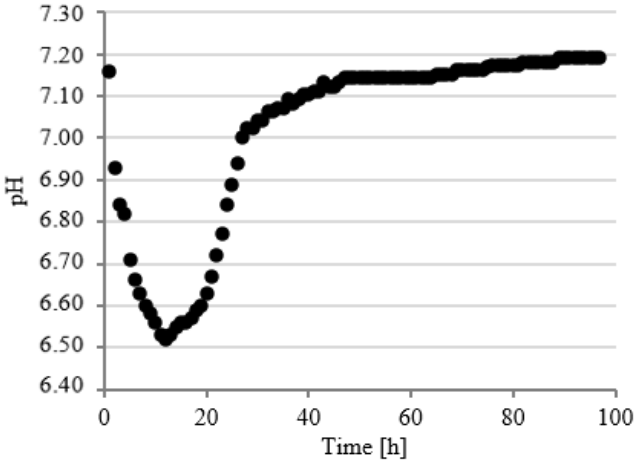
Figure 11. Course of pH changes in series 4.